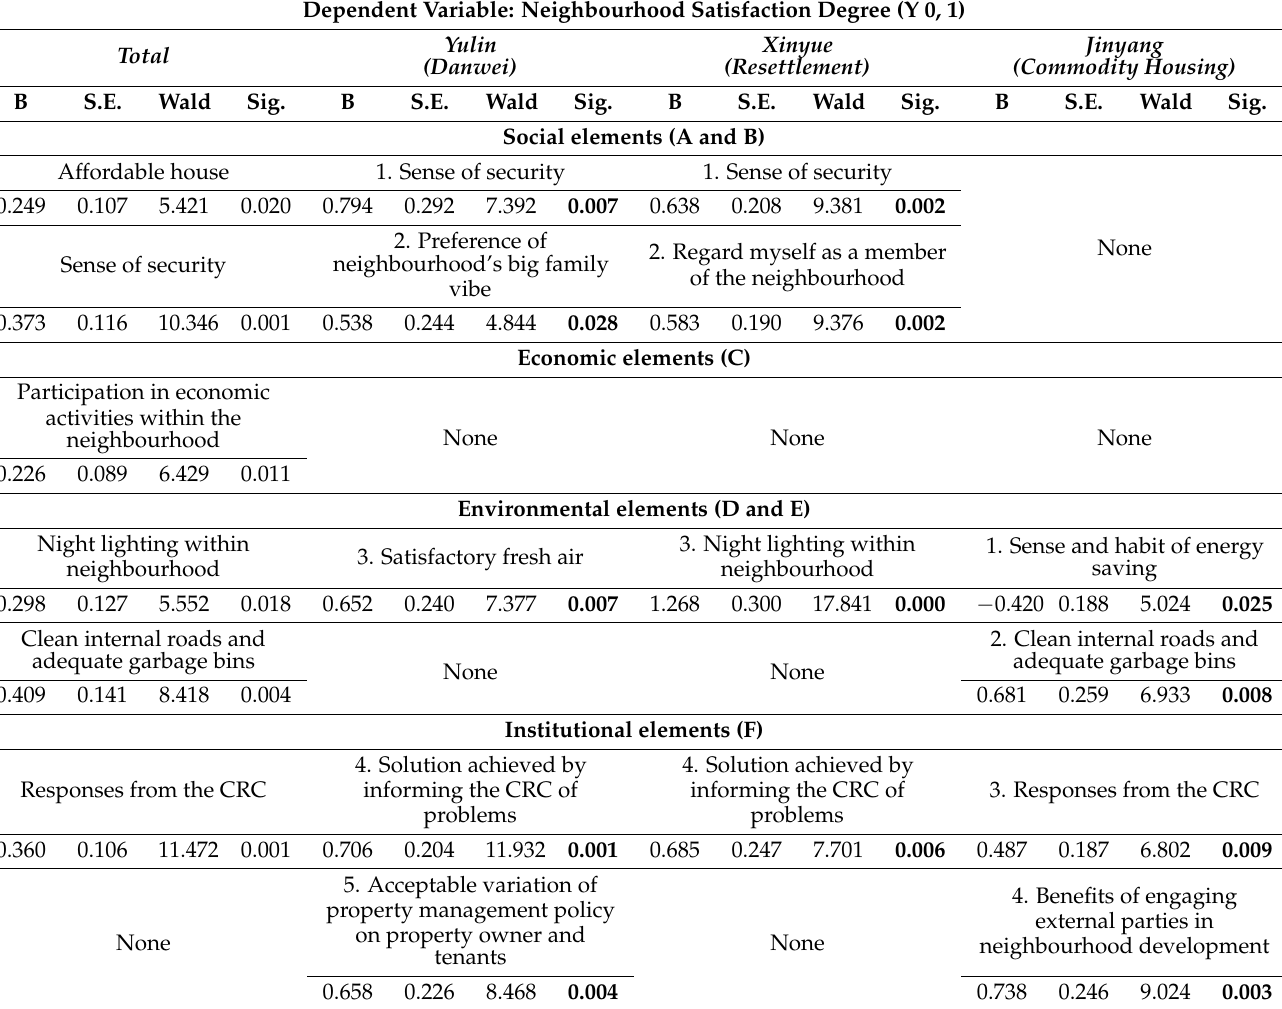
Table 4. Model 1 (including sustainability factors and neighbourhood